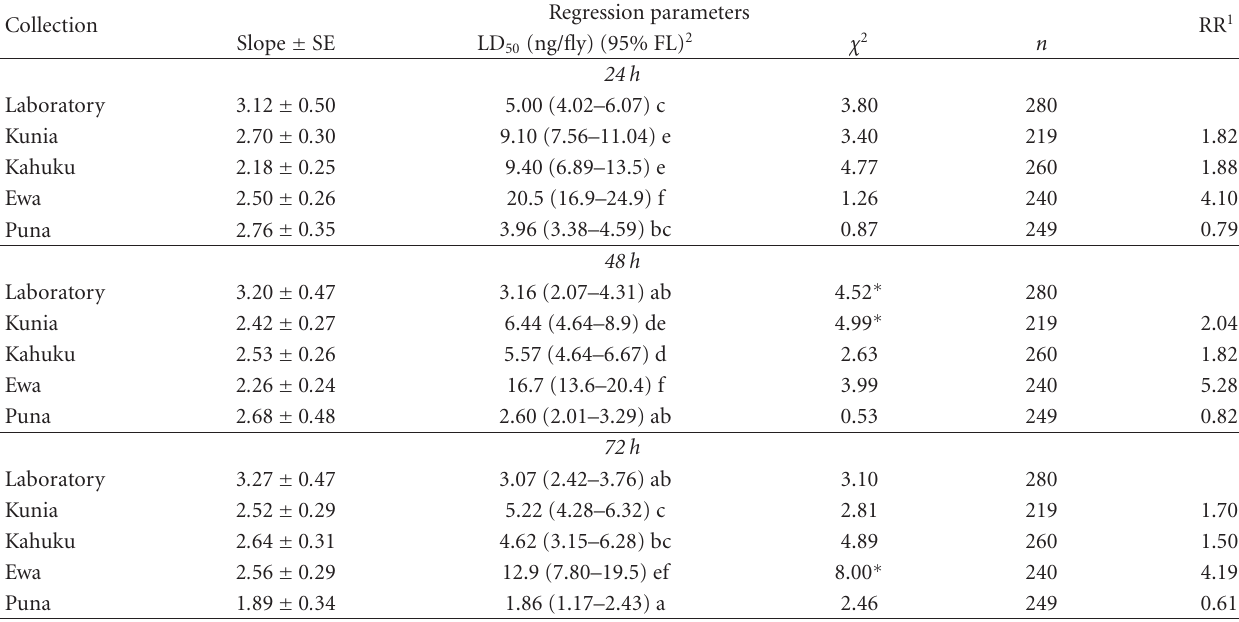
Table 2: Susceptibility and resistance to spinosad by topical application in Bactrocera cucurbitae flies (collected during August 2008) from wild populations and laboratory strains after 24, 48, and 72h.